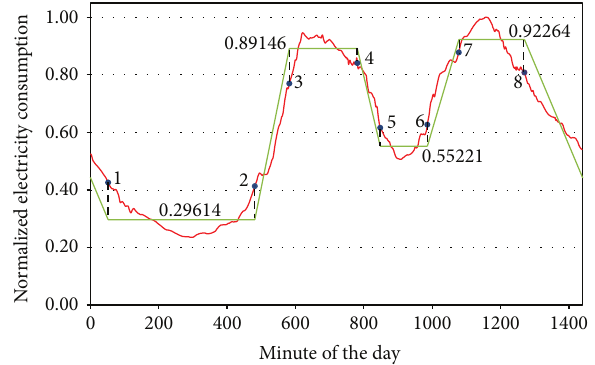
(iv) D: from minute 1078 (7) to 1270 (8) , with a value of 0.92264.